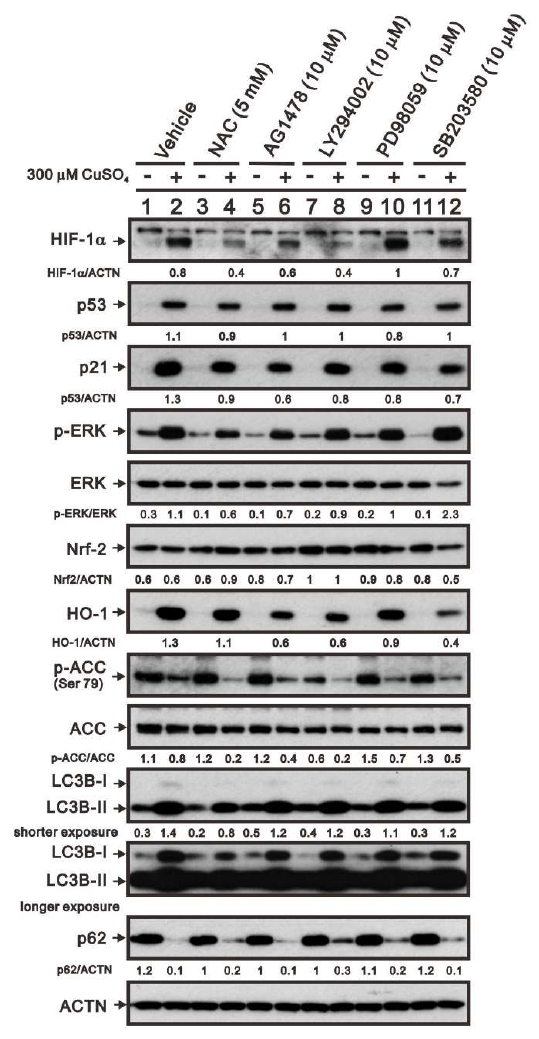
Figure 6. Mechanism by which copper sulfate increases HIF-1α expression. HeLa cells were incubated for 8 h with the indicated compounds in the absence (-) or presence (+) of 300 μM copper sulfate. Cell lysates were then subjected to western blot analysis using antibodies against HIF-1α, p53, p21, total and p-ERK, Nrf2, HO-1, total and p-ACC, LC3B, and p62. ACTN served as the protein loading control. The results are representative of three independent experiments. Protein bands were quantified through pixel density scanning and evaluated using ImageJ, version 1.44a (http://imagej.nih.gov/ij/). The fold (shown above the bands) was normalized to the internal control (ACTN). Phosphorylated ERK and ACC after normalization of their respective total proteins are shown as fold